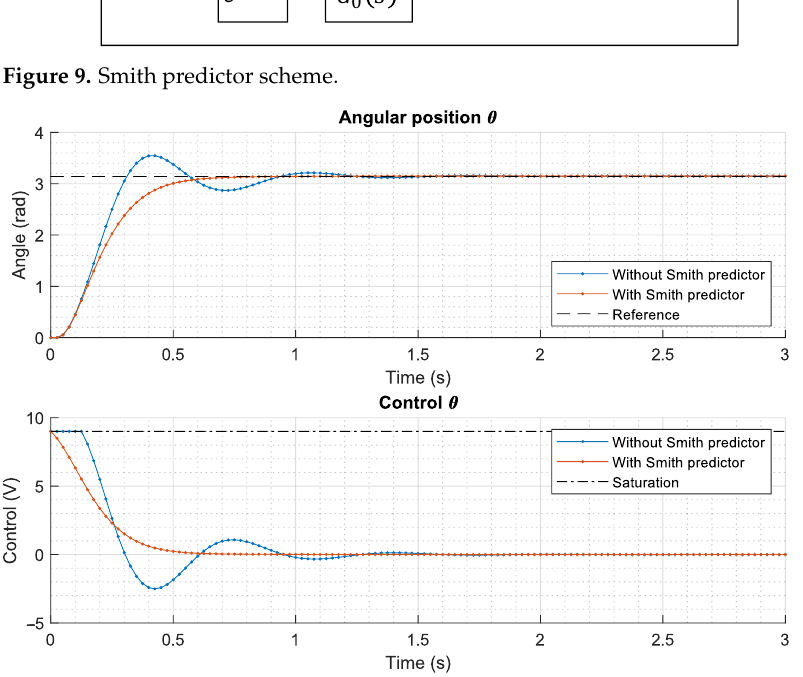
Figure 10. Smith predictor scheme